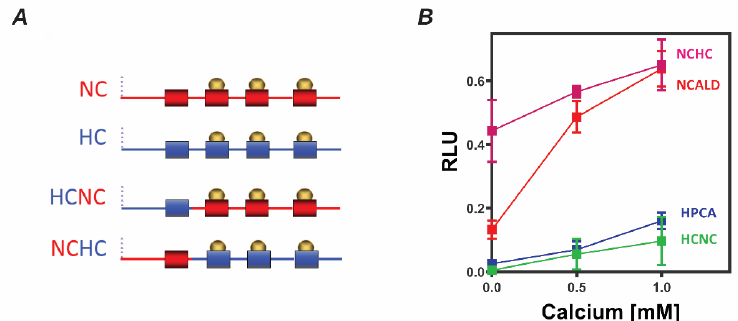
Figure 2. The N-terminal region of NCALD is necessary for the binding to S100B in vitro: ( A ) Chimeric constructs of NCALD and HPCA were created where the N-terminal region including the EF1 hand was swapped between the two proteins. EF hands are represented by filled rectangles. NCHC, for example, carried the N-terminal region of NCALD with the remaining portion of HPCA ( B ) Purified NCALD, HPCA, NCHC and HCNC were spotted onto nitrocellulose and the membrane was then incubated with S100B in the presence of indicated concentrations of CaCl 2 . Binding and analyses were carried out as indicated earlier. Data presented (mean ± SEM) was obtained from at least five independent experiments with three different protein preparations.